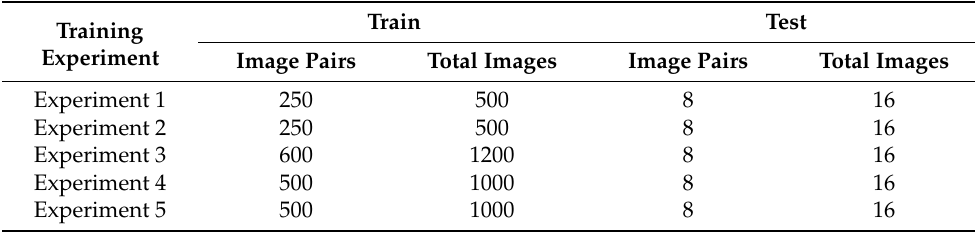
Table 1. Number of image pairs/images used to train each half of the network during each training